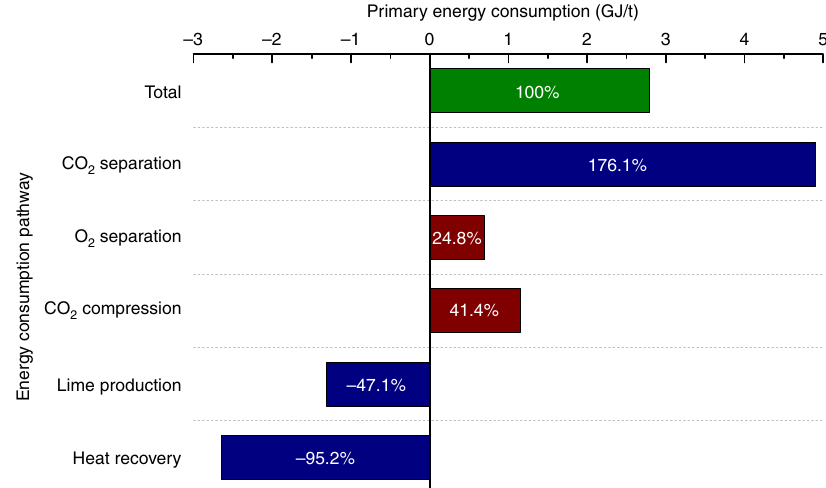
Fig. 5 Energy consumption characteristics of the CaL-LP scheme. Breakdown of the primary energy consumption for CO 2 emission reduction in an integrated steel mill implementing the CaL-LP scheme at a typical limestone feed percent of 5%. Green bar - the total incremental primary energy consumption; blue bar - heat-powered energy consumption steps; and red bar - electricity-powered energy consumption steps